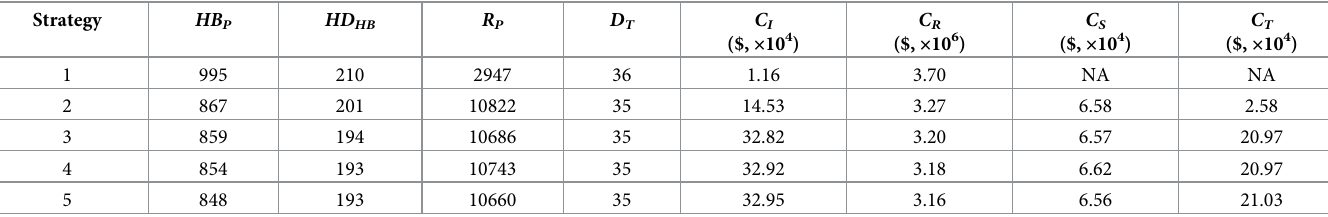
Table 6. Population stats in Eirunepe´ city in 2027 under five different strategies. Strategy